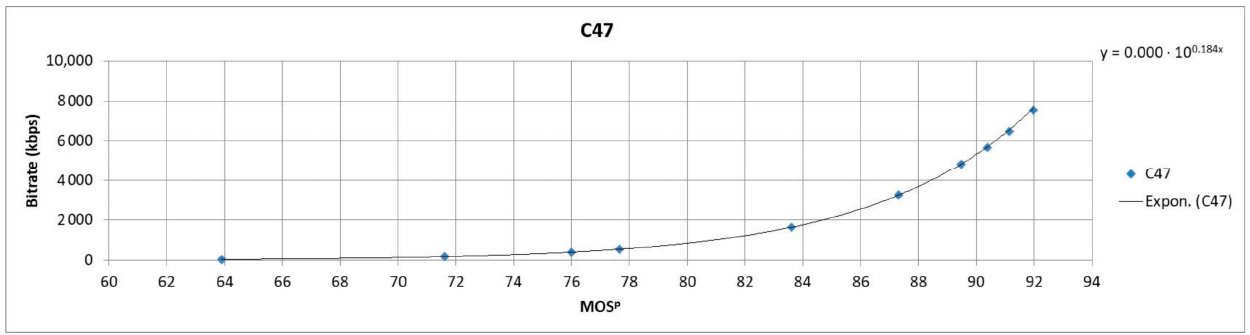
Figure 8. Bitrate- 𝑀𝑂𝑆 (cid:3043) curves for PA video sequence. Figure 9. Bitrate- 𝑀𝑂𝑆 (cid:3043) curves for SK video sequence.